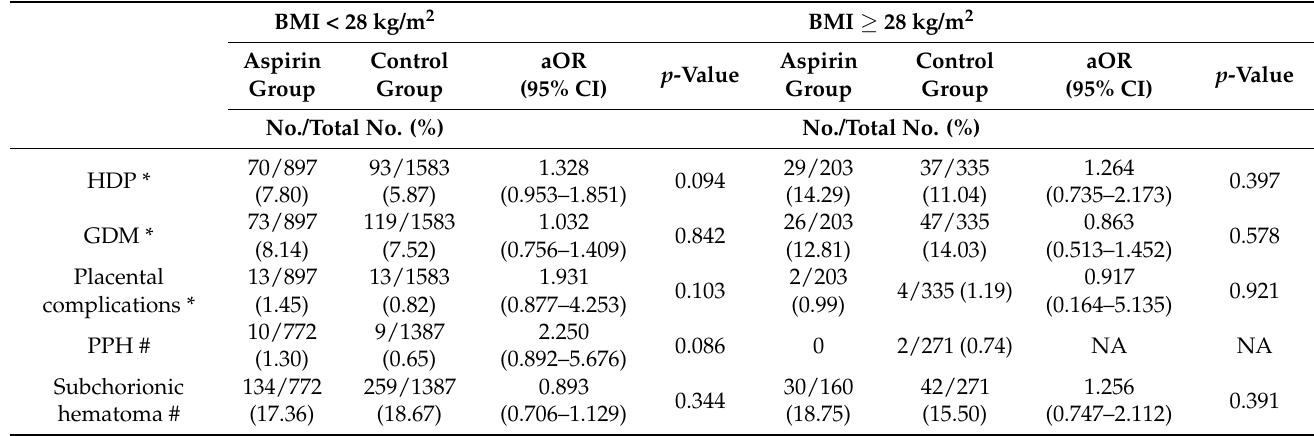
Table 5. Relationships between aspirin and pregnancy complications in different